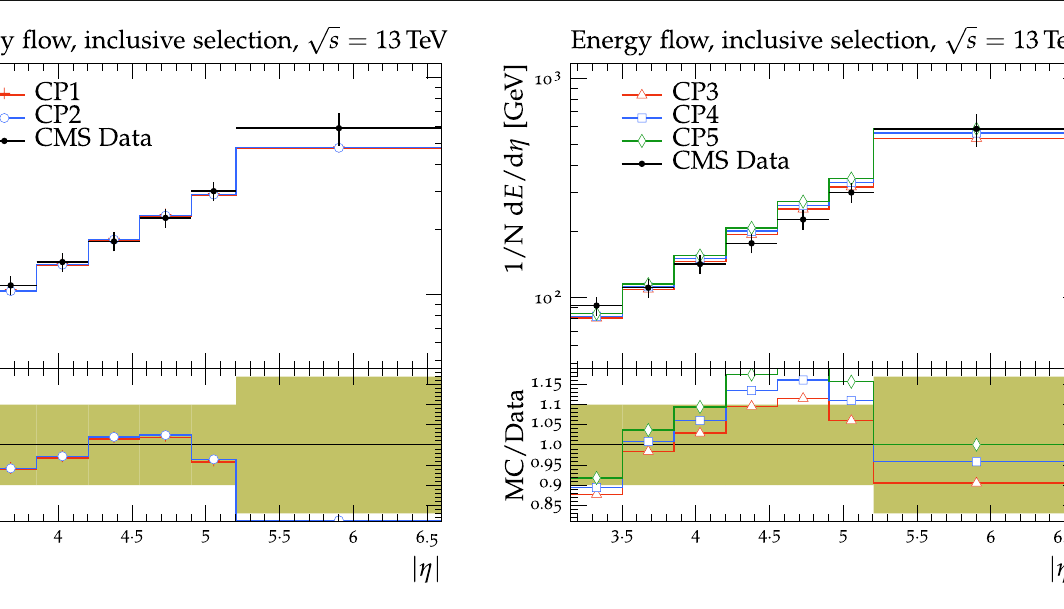
Fig. 15 The energy flow measured in an inclusive selection as a func- ulations to the data (MC/Data) is also shown, where the shaded band √ s = 13TeV analysis [47]. The tion of pseudorapidity, from the CMS indicates the total experimental uncertainty in the data. Vertical lines drawn on the data points refer to the total uncertainty in the data. Ver- data are compared with the CMS pythia 8 LO-PDF tunes CP1 and CP2 tical lines drawn on the MC points refer to the statistical uncertainty in (left), and with the CMS pythia 8 NLO-PDF tune CP3 and the CMS pythia 8 NNLO-PDF tunes CP4 and CP5 (right). The ratio of the sim- the predictions. Horizontal bars indicate the associated bin width